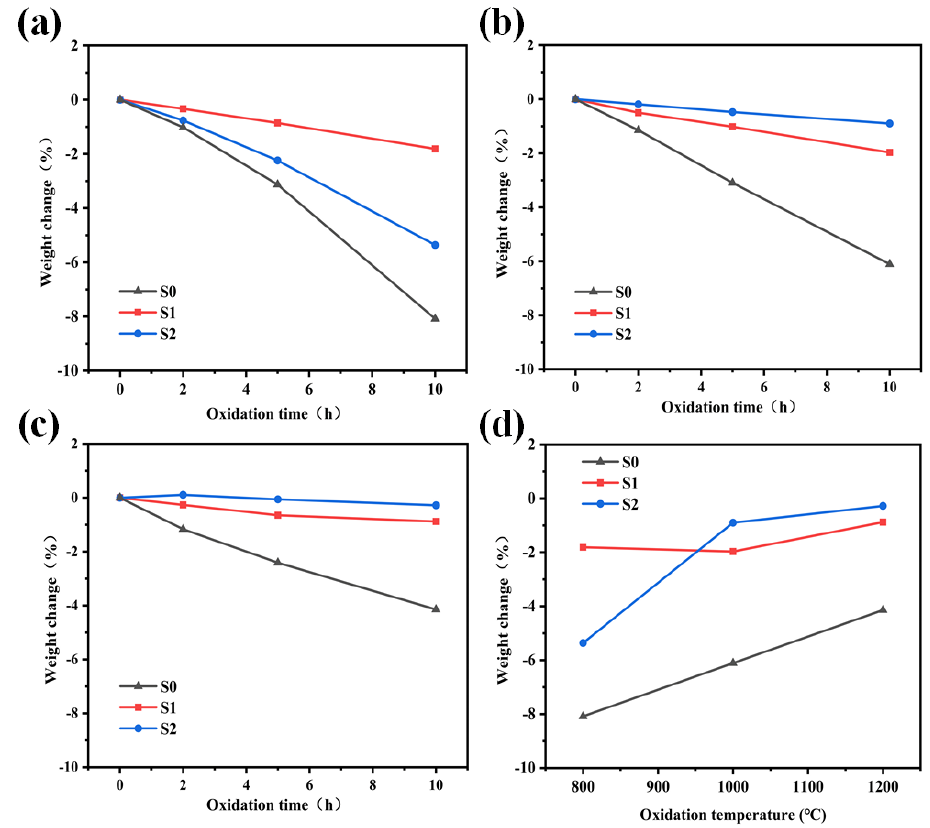
Fig. 4 Weight changes of the as-prepared composites after the oxidation for 10 h at (a) 800 ℃ , (b) 1000 ℃ , and (c) 1200 ℃ . (d) Total weight change of the as-prepared three